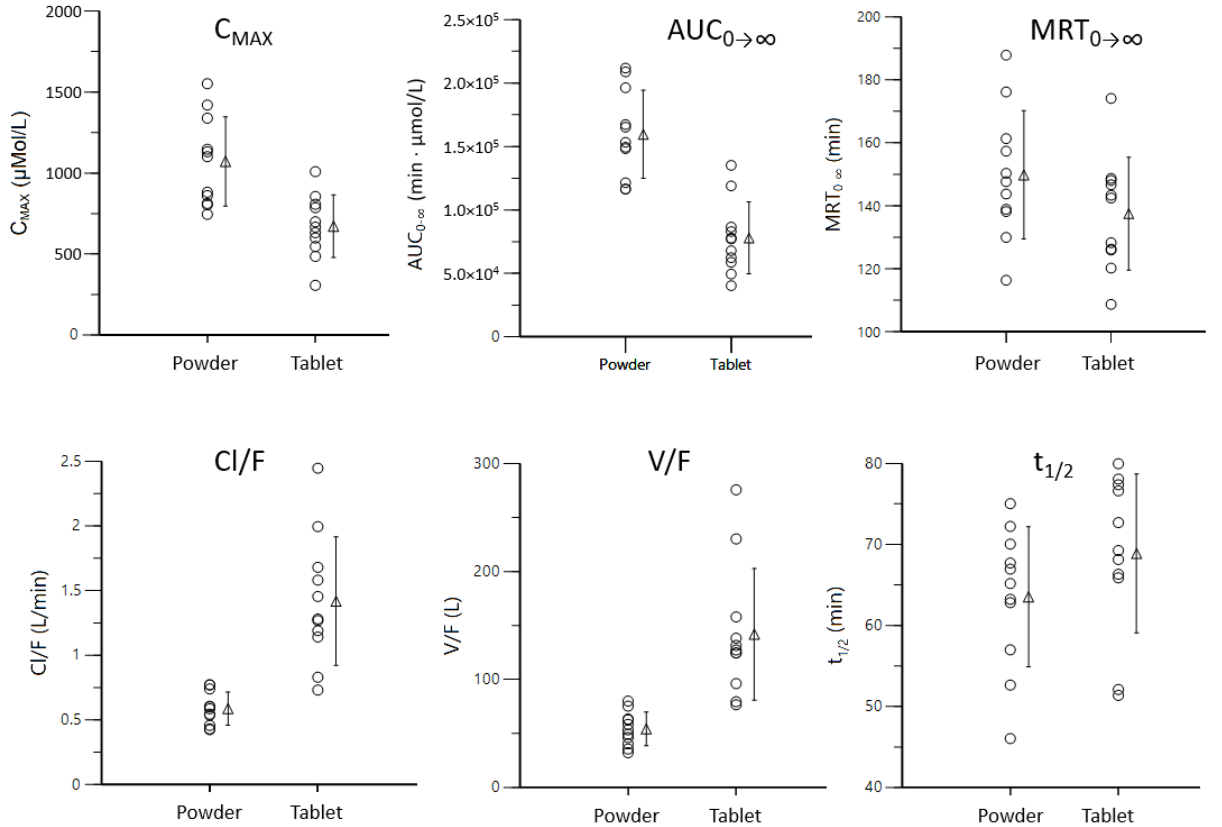
Figure 2. Individual distribution ( ○ ) of the main pharmacokinetic parameters obtained by non-compartmental techniques and their mean ( ∆ ) and SD.